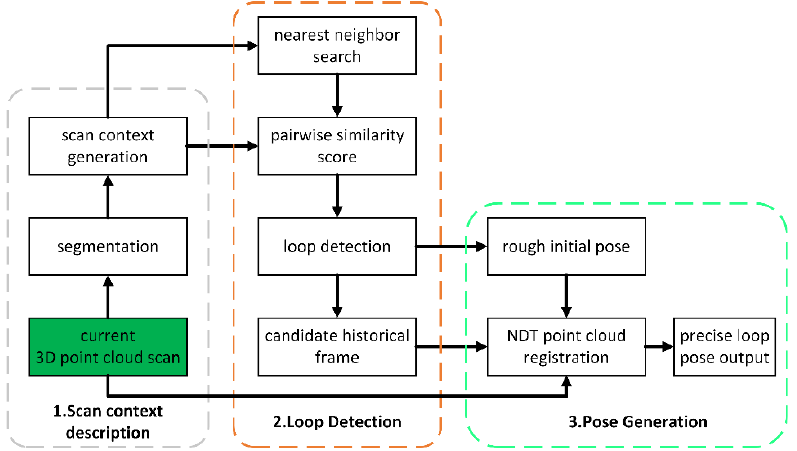
Figure 2. Scan context-based loop closure detection, current 3D point cloud scan is the start of this process. Which can provide loop closure detection position for offline mapping position optimiza- tion.